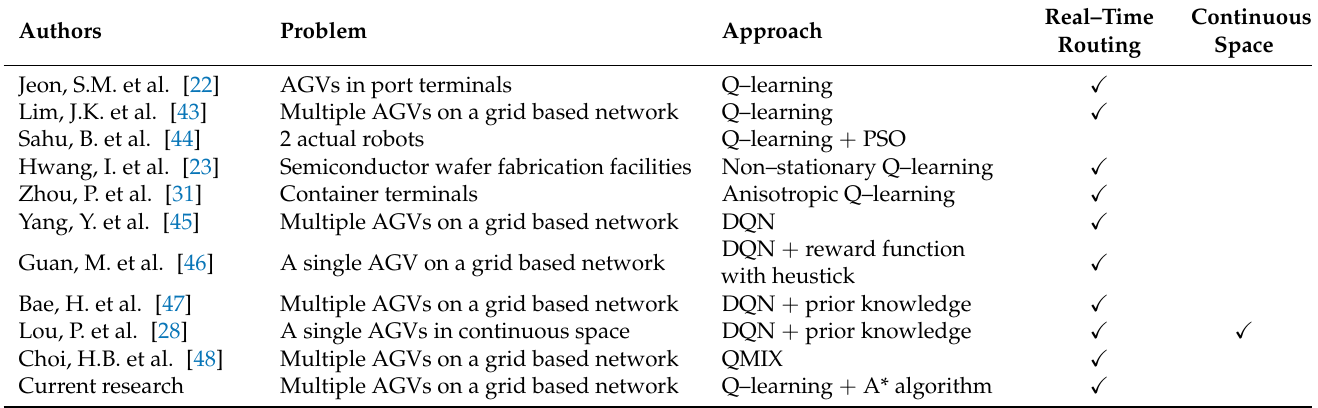
Table 1. Investigated studies using different approaches of reinforcement learning